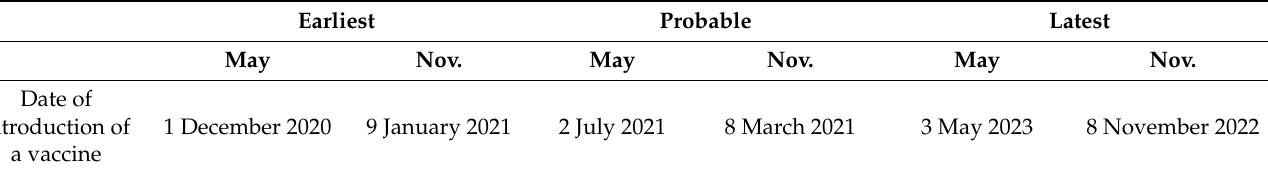
Table A8. Introduction of a